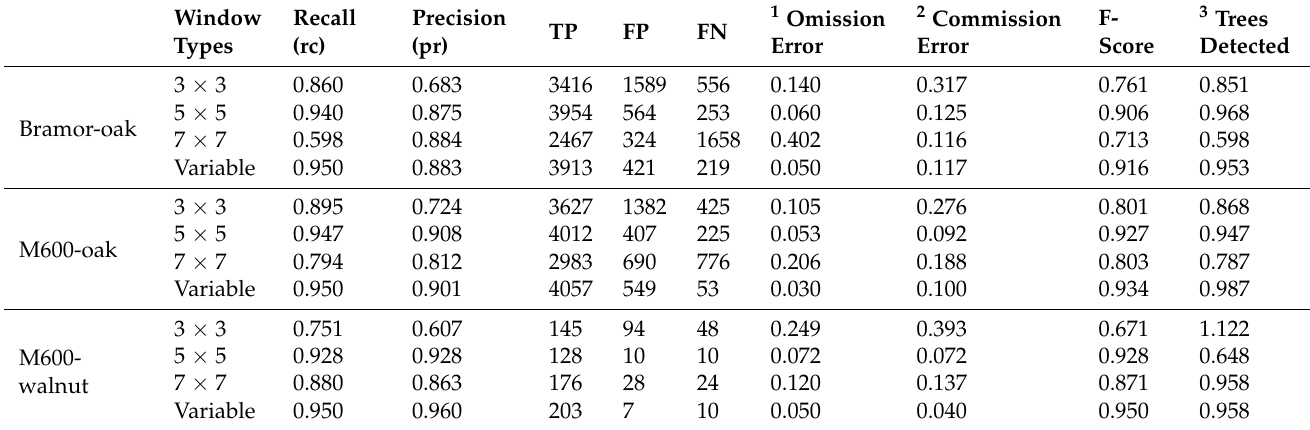
Table 3. Comparison of different accuracy parameters for the two plantations using different UAS platforms. Recall, precision, and detection rates are presented by using manually detected treetops as a reference for the accuracy assessment.